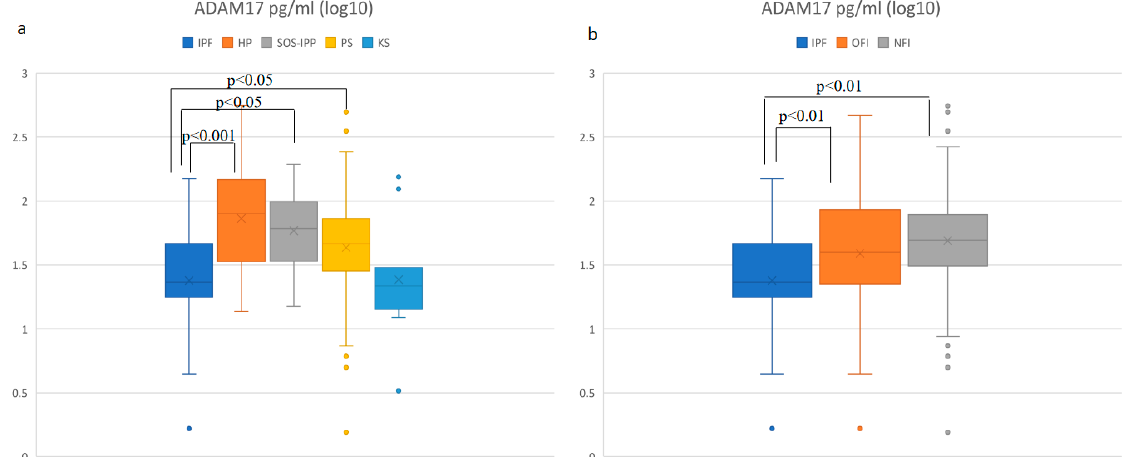
Figure 3. Comparison (log10) of ADAM17 concentration in BALF: ( a ) in different DPLD groups and control group, ( b ) in idiopathic pulmonary fibrosis (IPF), other fibrosis than IPF group (OFI) and non-fibrosis group (NFI). Idiopathic pulmonary fibrosis (IPF)—median: 23.2 pg/mL, interquartile range (IQR): 28.6; hypersensitivity pneumonitis (HP)—median: 82.0 pg/mL, IQR: 120.3; connective tissue disease-associated interstitial lung disease (CTD-ILD)—median: 61.3 pg/mL, IQR: